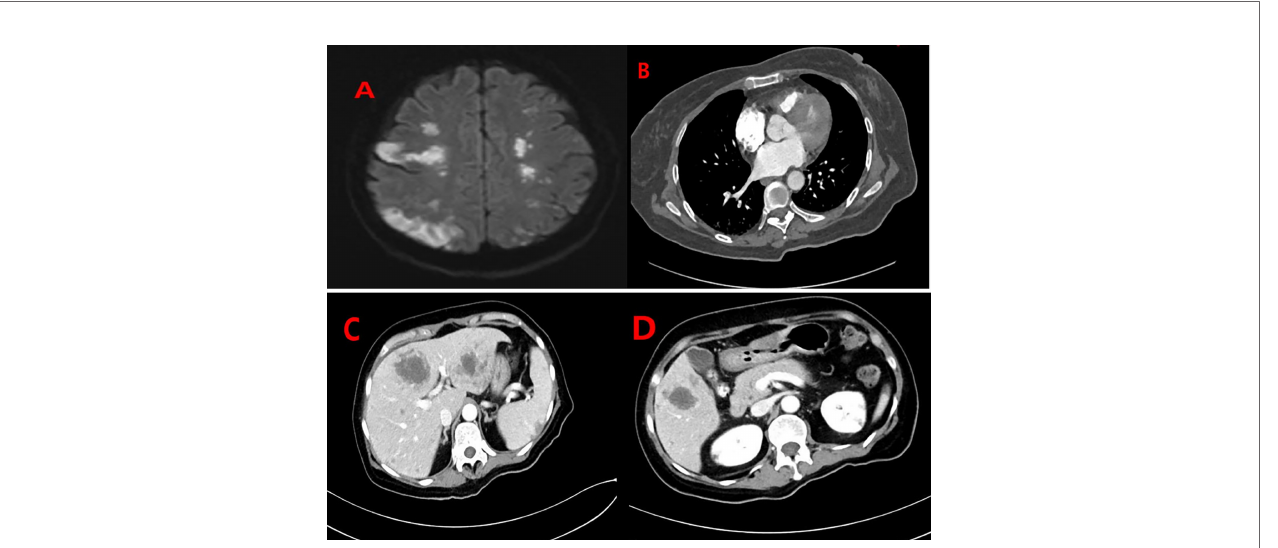
FIGURE 4 | (A) MRI of the brain showed multiple lesions in the bilateral brain representing cerebral infarctions. Contrast-enhanced whole-body CT of the patient: (B) Filling defects in the segmental pulmonary artery of the right lower lobe were also seen, indicating the presence of thromboemboli. (C, D) There were multiple lesions in the abdominal cavity (involving the kidneys, liver, spleen, left adrenal gland, and left pelvic side and bilateral inguinal lymph